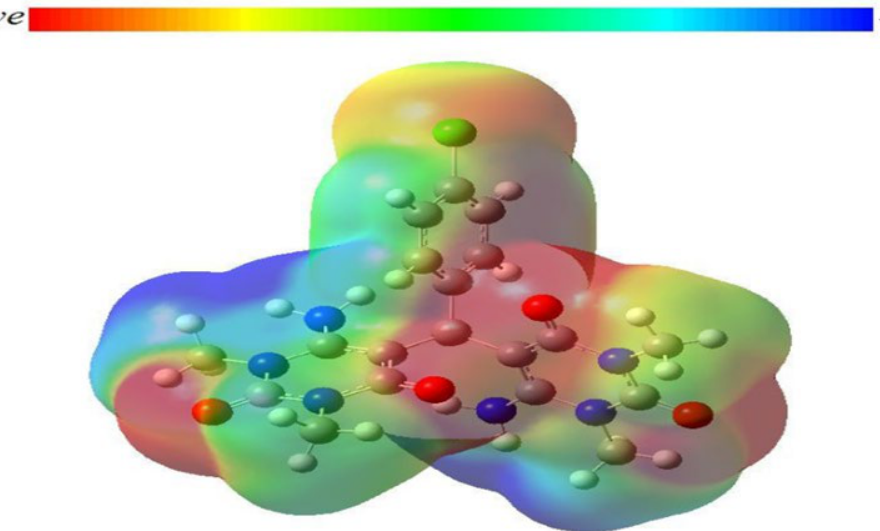
Figure 4. Molecular electrostatic potential (MEP) 3D plot of the investigated